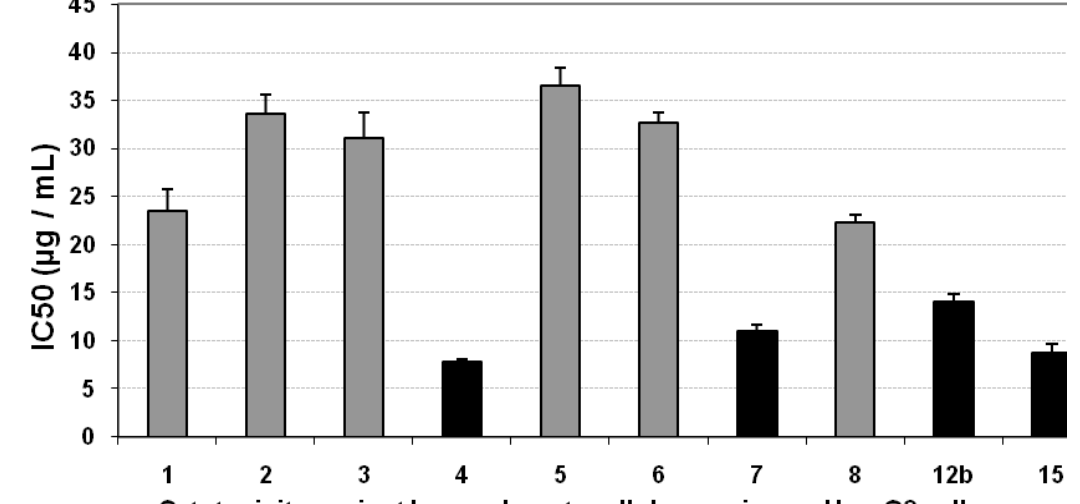
Figure 1. Cytotoxicity (IC50, µg/mL) of different tested compounds against human Hep-G2 cells 48 hours of incubation. The grey bars represent non-cytotoxic compounds, and the black bars represent the promising cytotoxic compounds. Data are representing mean value of IC50 ±